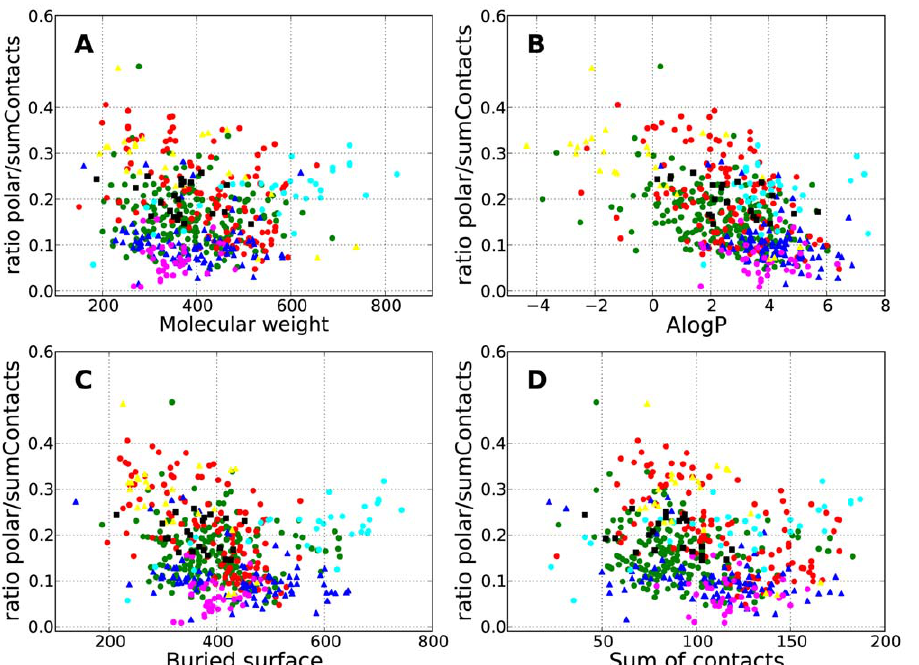
Figure 4. Calculated properties versus interaction profile. The polar ratio (as number of polar contacts divided by the total [polar + apolar] number of contacts) versus molecular weight (A), AlogP (B), buried area upon binding (C) and sum of contacts (D) for protein complexes with synthetic small molecules. Different colors denote SCOP families: Protein kinase catalytic subunit (green), nuclear receptor ligand-binding domain (blue), eukaryotic proteases (red), retroviral proteases – retropepsin (cyan), reverse transcriptase (magenta), Higher-molecular weight phosphotyrosine protein phosphatases (yellow), HSP90 N-terminal domain (black). For clarity, only SCOP families binding to more than 20 different ligands are shown.